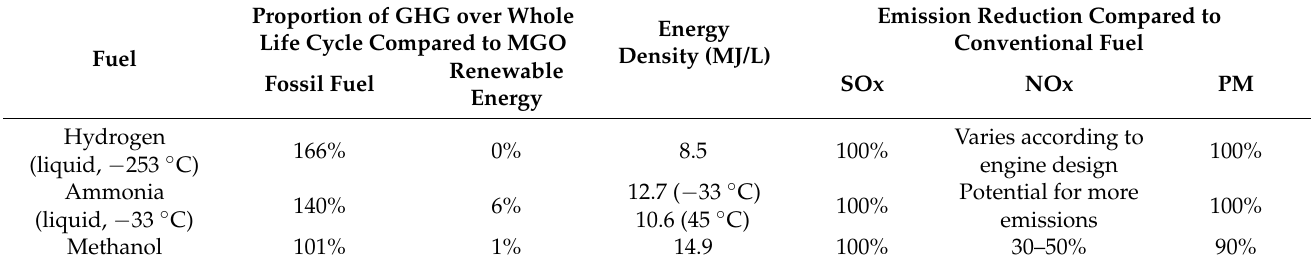
Table 1. Compared with standard MGO, whole-life-cycle GHG emissions of ammonia, hydrogen, and methanol